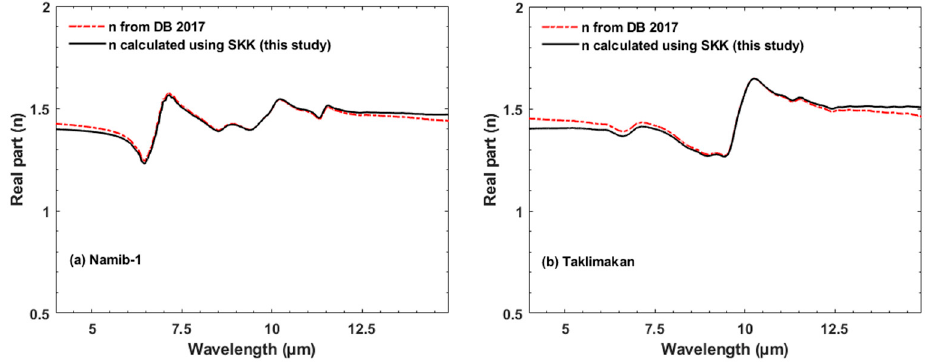
Figure 3. The real part ( n ) for Namib-1 ( a ) and Taklimakan ( b ) samples [20] that were derived from k using the Lorentz dispersion theory (red line) [20] and our SKK technique (black line).